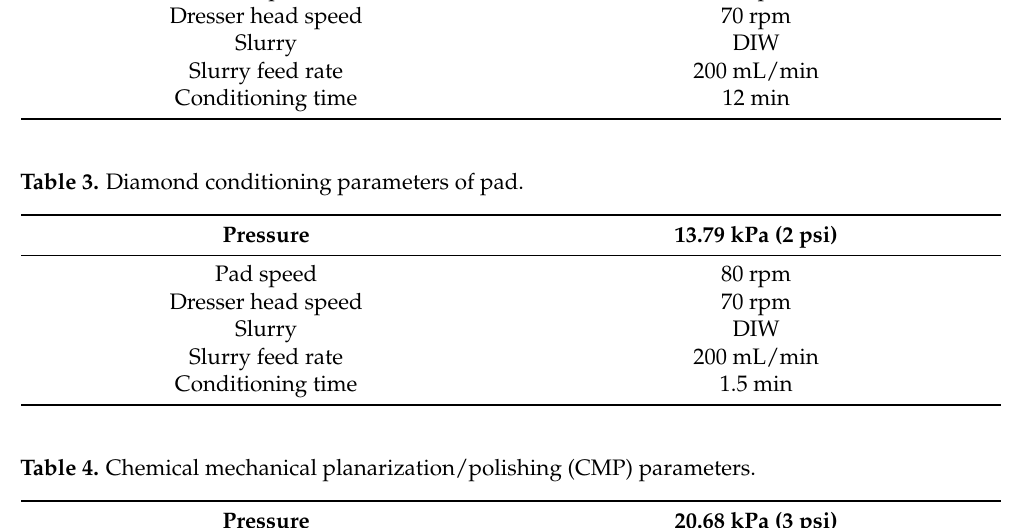
Table 4. Chemical mechanical planarization/polishing (CMP) Table 3. Diamond conditioning parameters of pad.